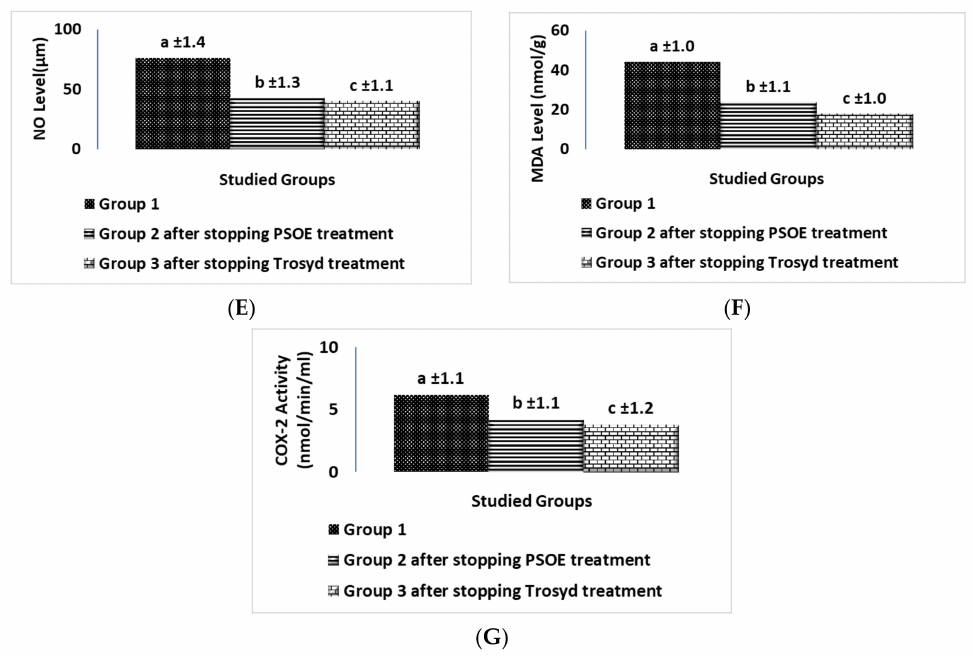
Figure 7. Reoccurrence of inflammation after stopping therapy for 21 days in the human study. ( A ) Collagenase, ( B ) elastase, ( C ) hyaluronidase, ( D ) tyrosinase, ( E ) nitric oxide (NO), ( F ) malon- dialdehyde (MDA), ( G ) cyclooxygenase2 (COX-2) levels; Group 1, who did not receive any skin treatment (for at least 2–3 months); Group 2, (PSOE treatment group) after stopping treatment for 21 days; Group 3, (TROSYD treatment) after stopping treatment for 21 days. Data are shown as mean ± SD for 20 volunteers in each group. Statistical significance was detected at p ≤ 0.05; means reported with the same letters (a, b, c) were not significantly different.